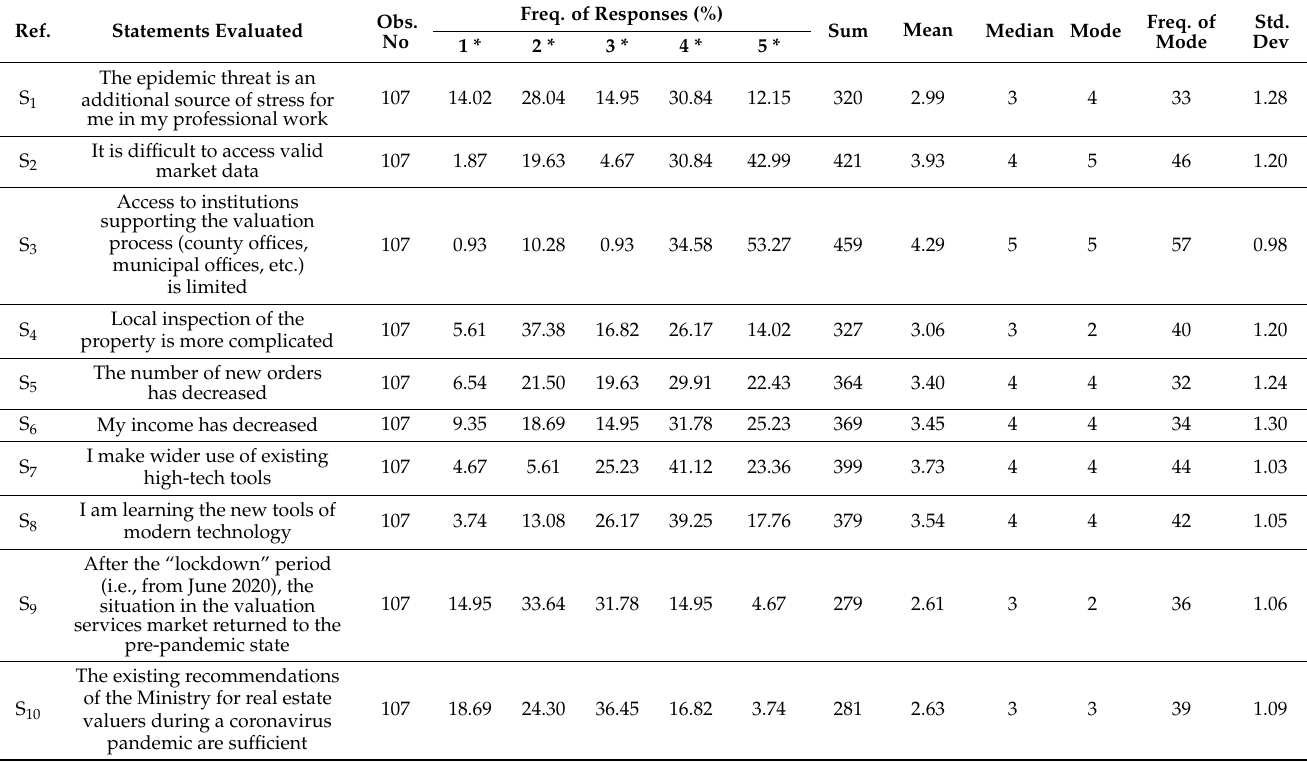
Table 2. Descriptive statistics of respondents’ answers to survey